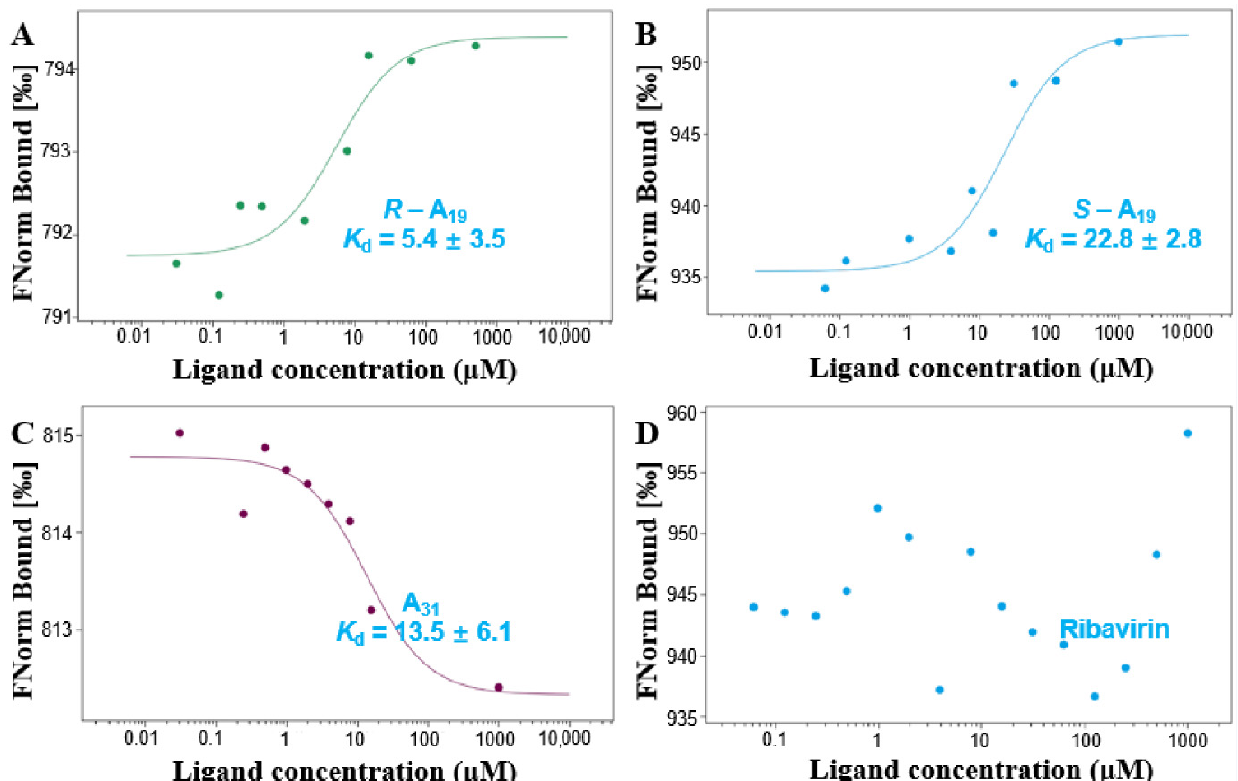
Figure 8. Interactions between compounds R ‐ A 19 ( A ), S ‐ A 19 ( B ), A 31 ( C ), or Ri ( D ) with helicase, measured by microscale thermophoresis. The inhibitory activity of target compounds and Ri against the TMV helicase at 200 μ M.